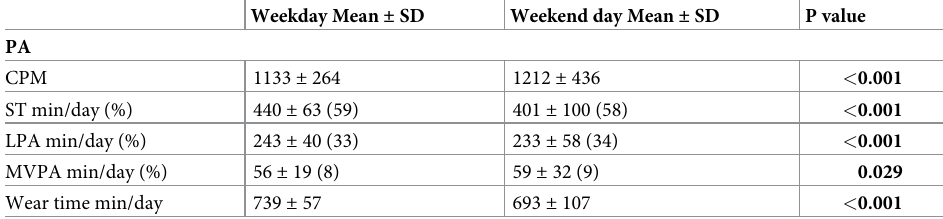
Table 2. PA patterns during week and weekend day separately (N = 503).